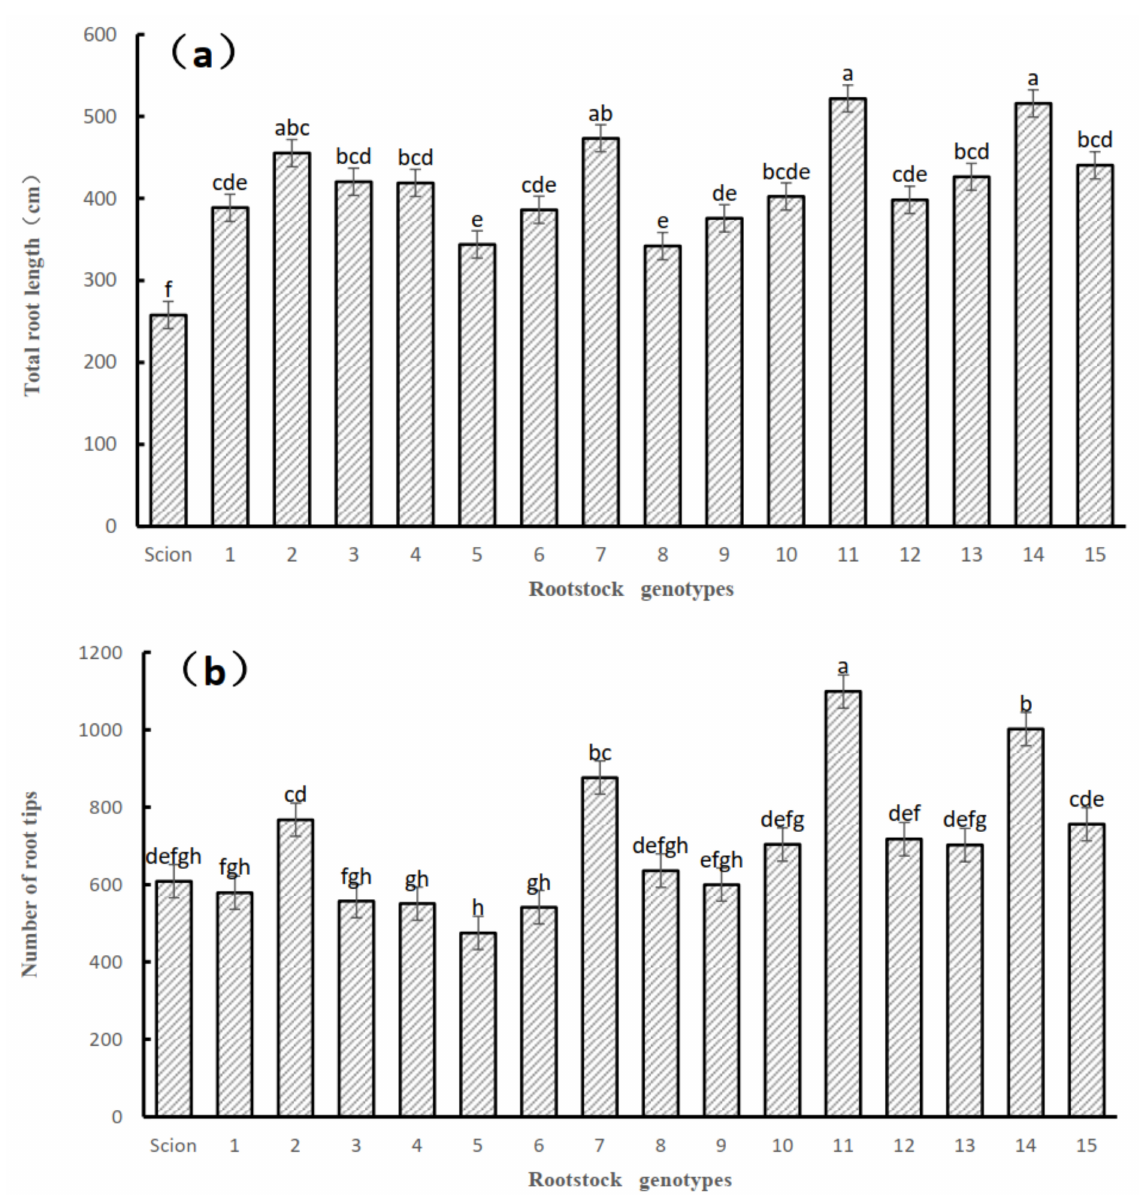
Figure 2. The total root length and number of root tips of grafted tomatoes with the 15 rootstock genotypes: ( a ) is the total length of all taproots and lateral roots; ( b ) is the number of root tips, where the nongrafted scion is the control. The results are the mean ± SEs. The means within each column followed by different letters were significantly different among graft combination treatments, according to Tukey’s test ( p <